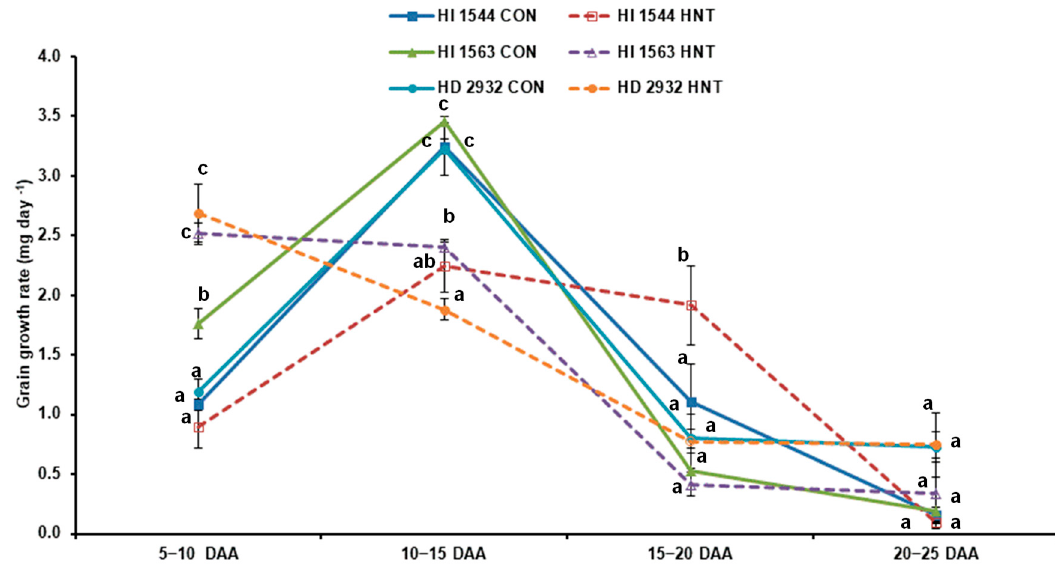
Figure 5. Grain growth rate of wheat genotypes grown under control (CON) and HNT conditions at 5–10, 10–15, 15–20, and 20–25 DAA. Values show mean ± SE. Data were obtained from three replications of each genotype. The separation of means was carried out using Duncan’s post hoc test ( p < 0.05). Means with different letters are significant.